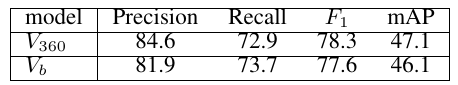
Table 3. Precision, Recall, F 1 score and mAP for object detection on the UAV 360 dataset, achieved by the variant V 360 of our method and the baseline V b